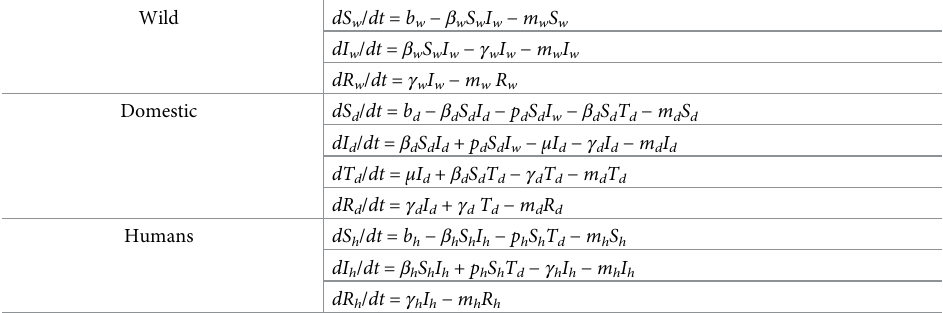
Table 2. ODE systems of our model with three host compartments (species), composed of wild reservoir hosts, intermediate domestic animal hosts, and human hosts.